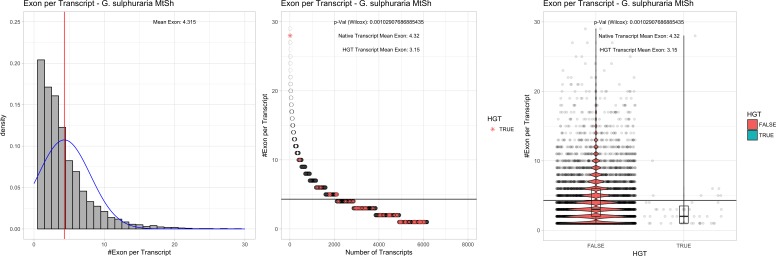
Exon/Intron – Galdieria sulphuraria MtSh: (Left) Mid) Cumulative %GC distribution of transcripts.Red line shows the average, blue line a normal distribution based on the average value. The data is categorical (genes have either one, two, three etc. exons) and does not follow a normal distribution. (Mid) Ranking all transcripts based upon their number of exons. Red ‘*' demarks HGT candidates. As the number of exons was not normally distributed, transcripts were ranked by number of exons. In order to resolve the high number of tied ranks (e.g. many transcripts have two exons) a bootstrap was implied by which the rank of transcripts sharing the same number of exons was randomly assigned 1000 times. Wilcoxon-Mann-Whitney-Test applied for the determination of significant rank differences between the native gene and the HGT candidate subset. (Right) Violin plot showing the number of exons per transcript distribution across native transcripts and HGT candidates.